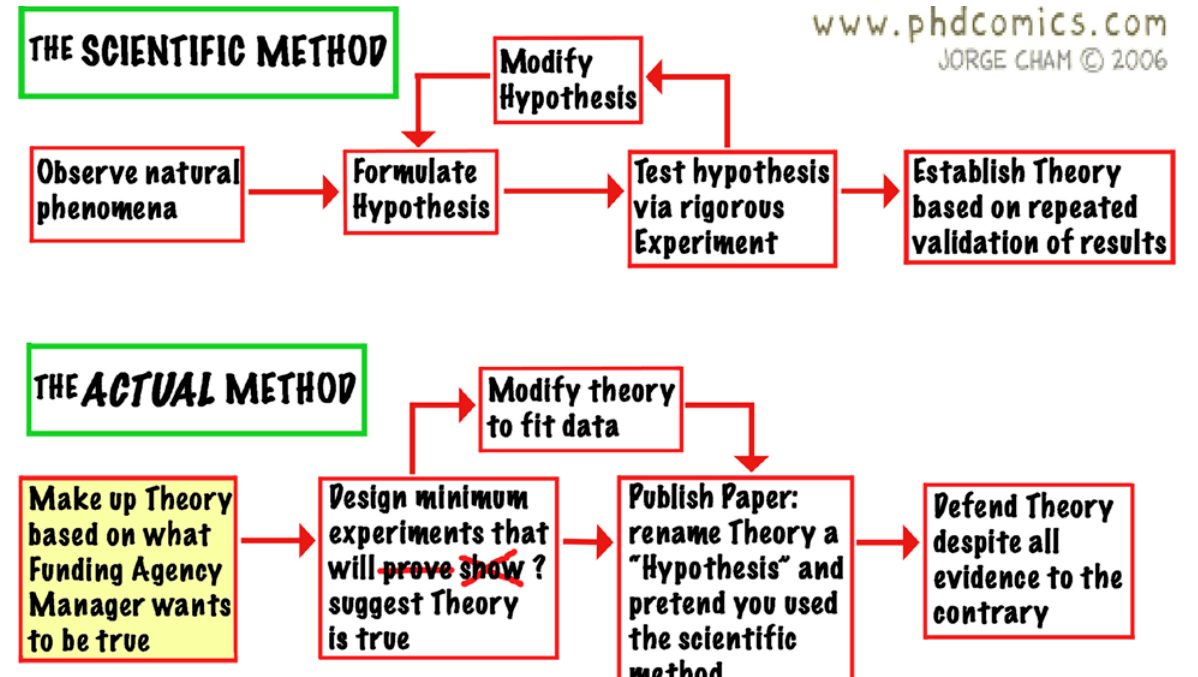
Figure 1. This cartoon by Jorge Cham, 2006, depicts the unfortunate trend from the scientific method to expediency in obtaining research